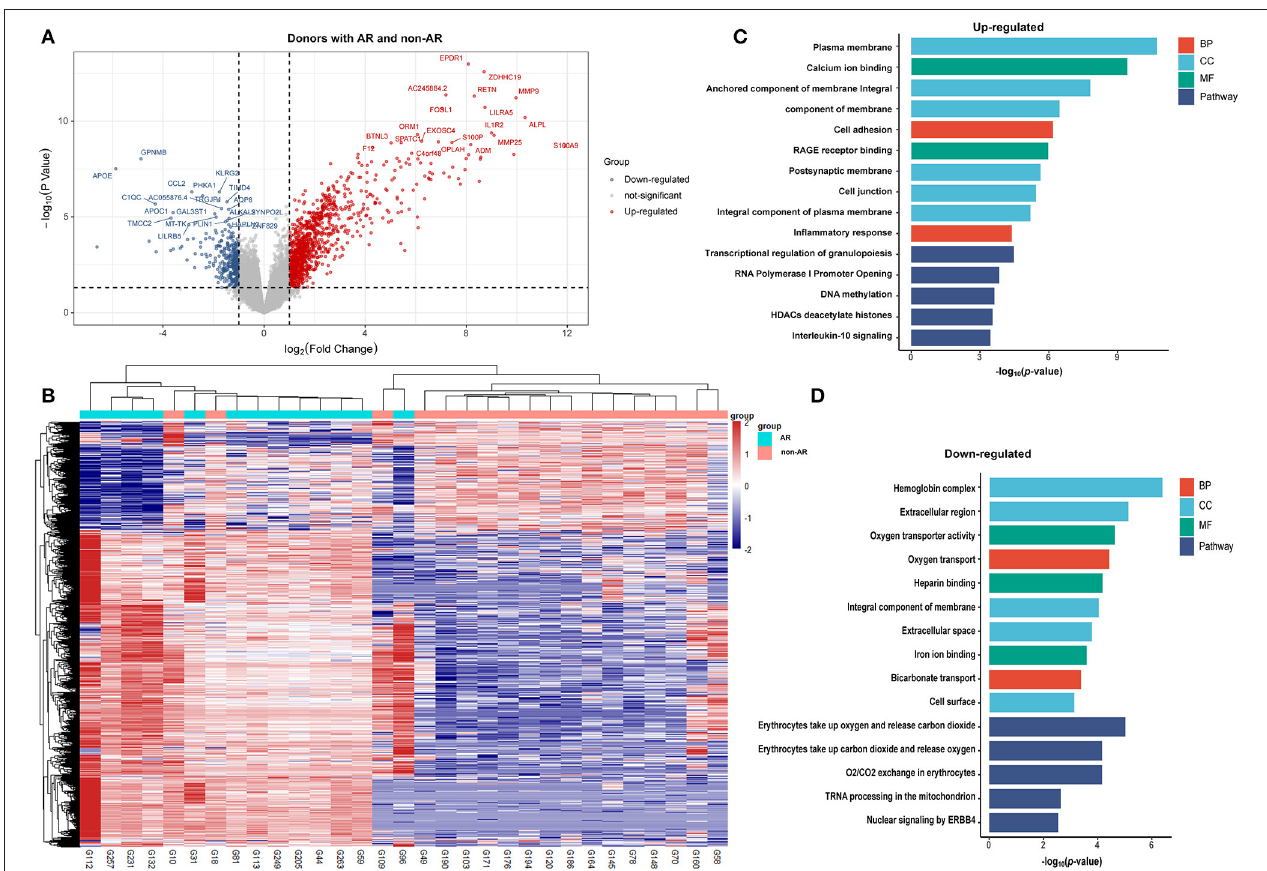
FIGURE 4 | DEGs and GO analysis (donors with AR and non-AR). Volcano map of DEGs in TCMR vs. non-AR recipients. Red represents upregulated genes, and blue represents downregulated genes. A total of 1472 upregulated and 505 downregulated genes were identified as DEGs in donors with AR ( n = 13) compared with non-AR ( n = 18). (B) Hierarchical clustering heatmap analysis of DEGs. Red represents upregulated genes, and blue represents downregulated genes. (C) GO and pathway analysis of upregulated DEGs. (D) GO and pathway analysis of downregulated